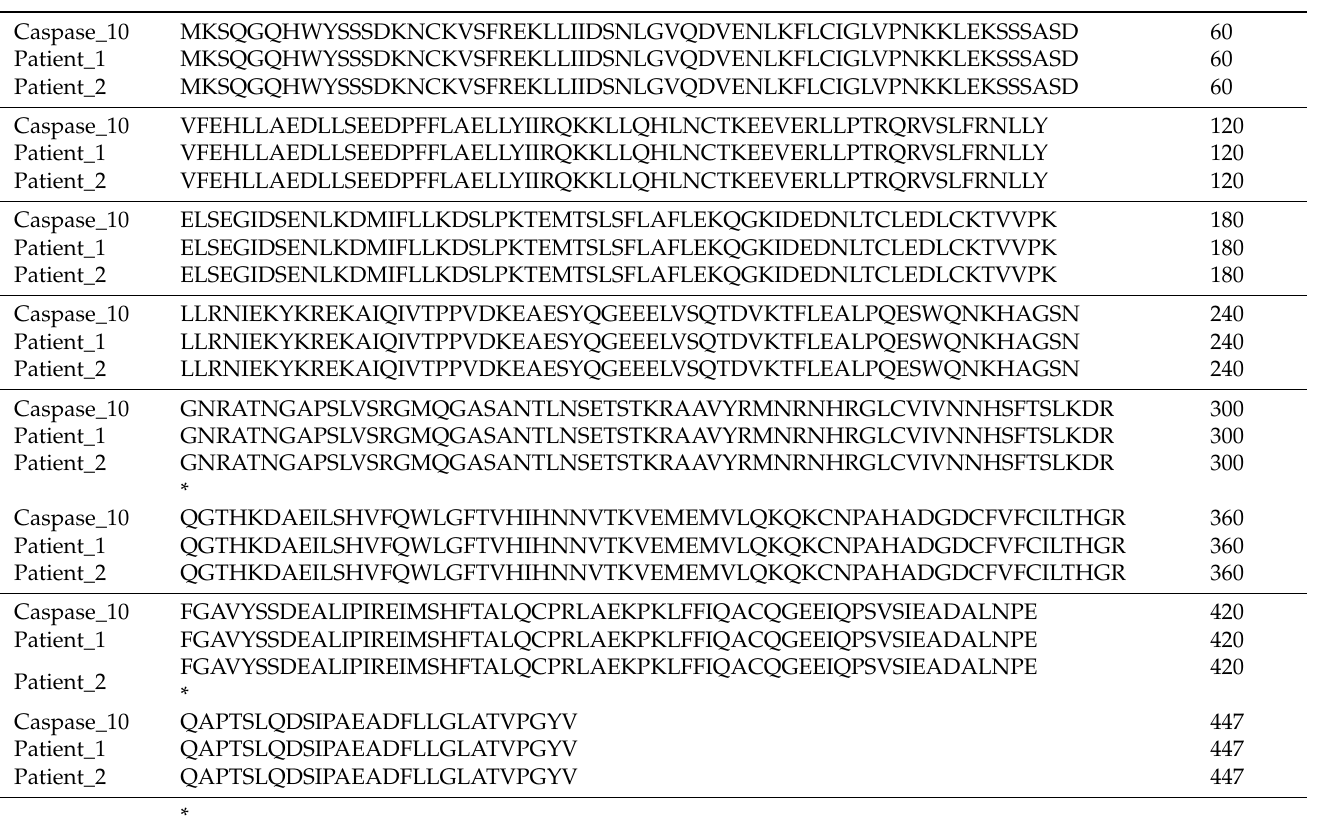
Table 3. Amino acid sequence alignment of Caspase 10 from the patients and the reported in UniProtKB–Q92851. *, amino acids which mutation has been implicated in ALPS, L285F [17], I406L [18], Y446C [14].